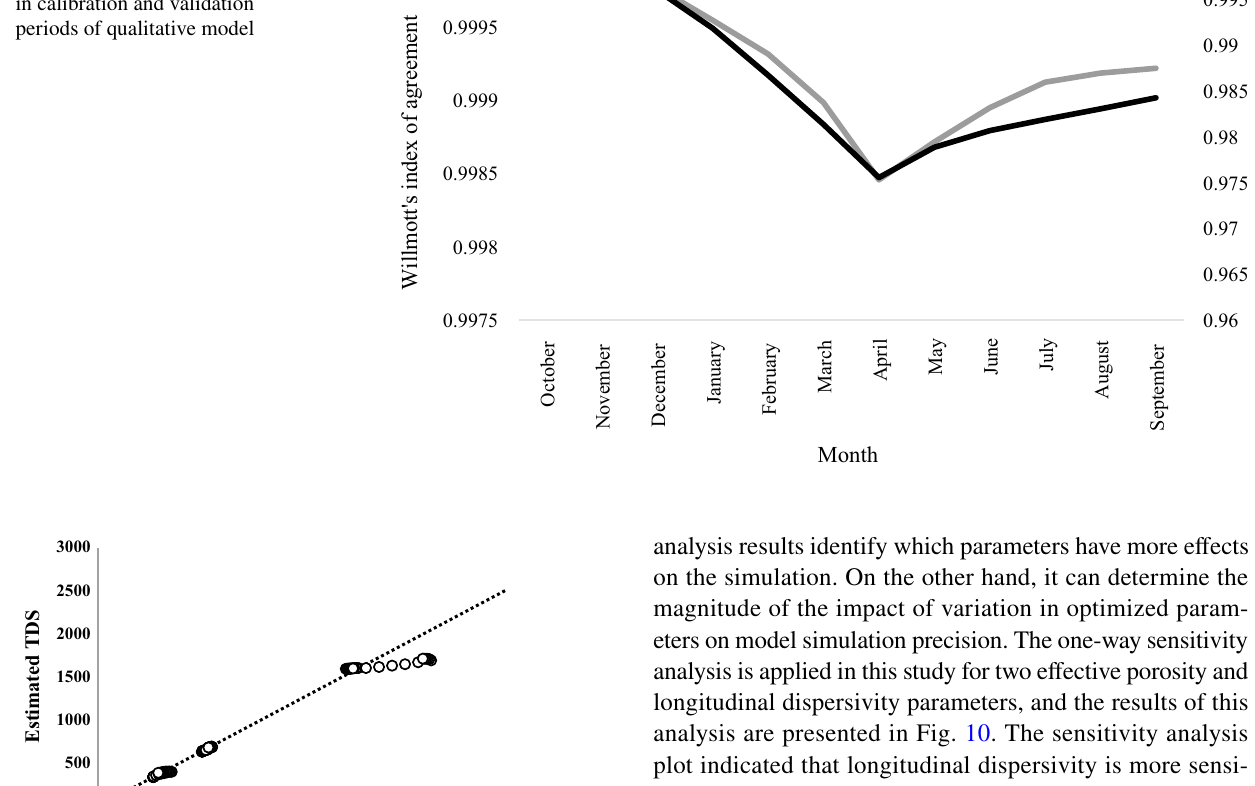
Fig. 7 Monthly time series of Willmott’s index of agreement in calibration and validation periods of qualitative model